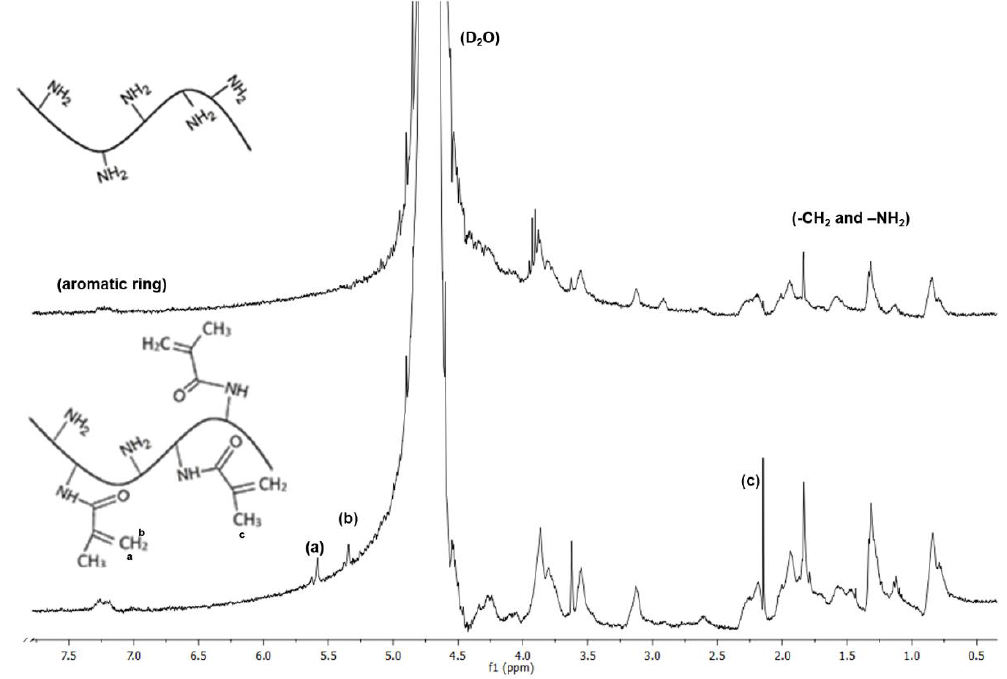
Figure 1. NMR spectra of the original and functionalized gelatin (GelMA). 219